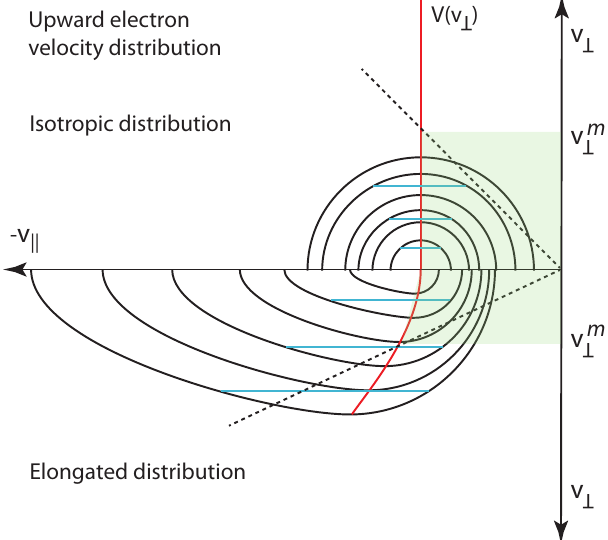
Fig. 4. Sketch of the upward electron distribution in velocity space. Upper half plane: isotropic shifted distribution. The shift is the (negative) upward electron velocity V (shown in red). The (blue) horizontals indicate the “thermal spread” v e (v ⊥ ) at three fixed per- pendicular velocities v ⊥ . Lower half plane: same for an elongated electron distribution (as implied by the measured parallel electron distribution in Fig. 1). In this case both current speed V (v ⊥ ) and “thermal spread” v e (v ⊥ ) increase at a larger amount with increas- ing v ⊥ than in the isotropic case. Dashed lines indicate the maxi- mum Buneman-unstable angles θ in velocity space. Green-shaded domains indicate ranges of Buneman-unstable perpendicular veloc- ities v ⊥ smaller than the maximum nominally unstable v m ⊥ . This domain is reduced for the elongated distribution suggesting that for the real elongated case the hole assumes elliptic shape in velocity space. Maser emission is then intrinsically